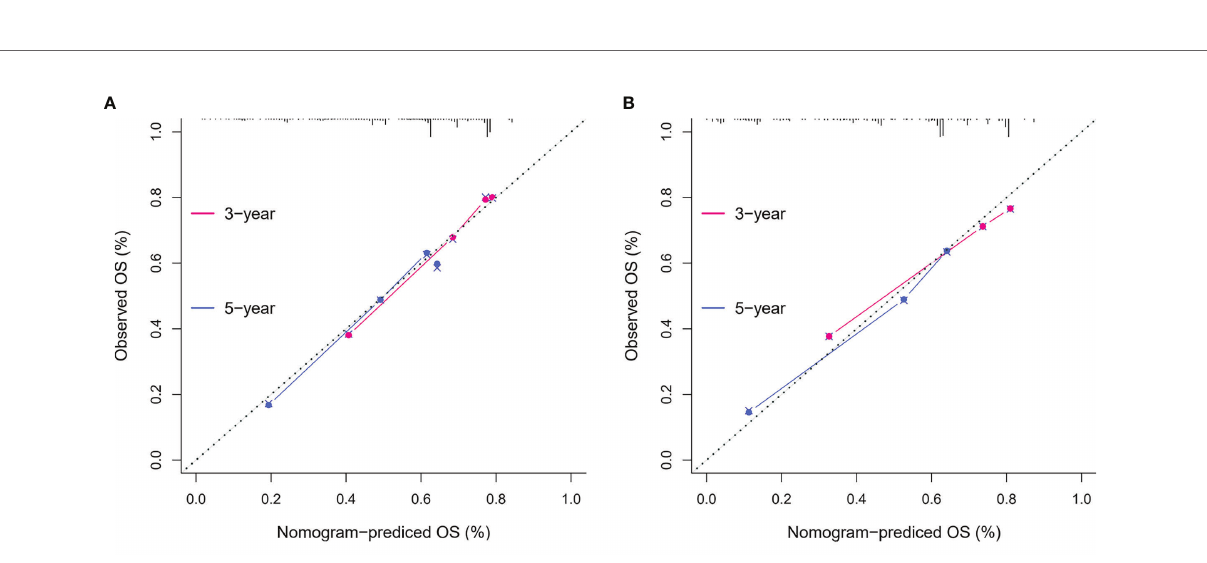
FIGURE 8 | The calibration curves on 3-year and 5-year OS of the nomogram. The x-axis represents the nomogram-predicted probability of overall survival, and the y-axis represents the observed overall survival. The reference line is 45°, which indicates perfect calibration. (A) Calibration curves of training set. (B) Calibration curves of the validation